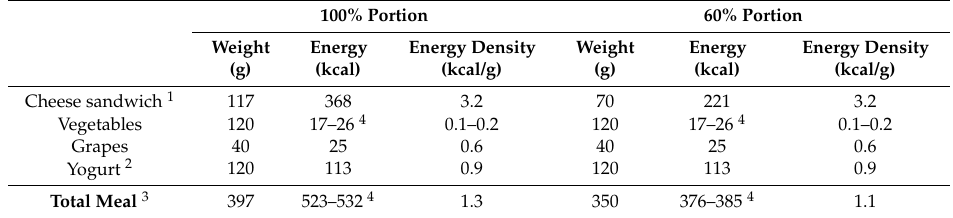
Table 2. Characteristics of the test meal provided at